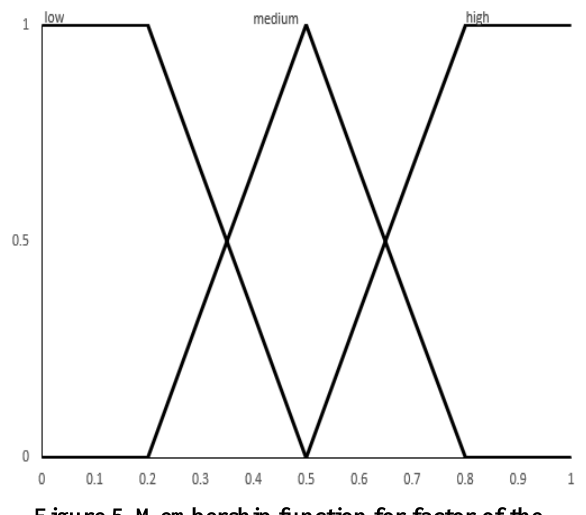
Figure 5. Membership function for factor of the number of duplicate delivered